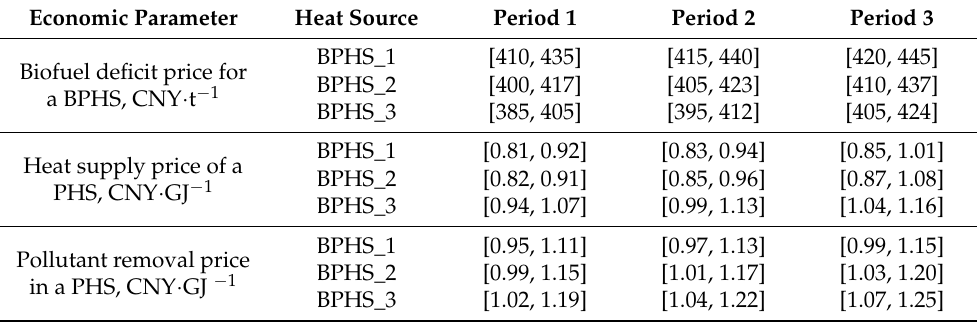
Table A4. Related economic parameters.